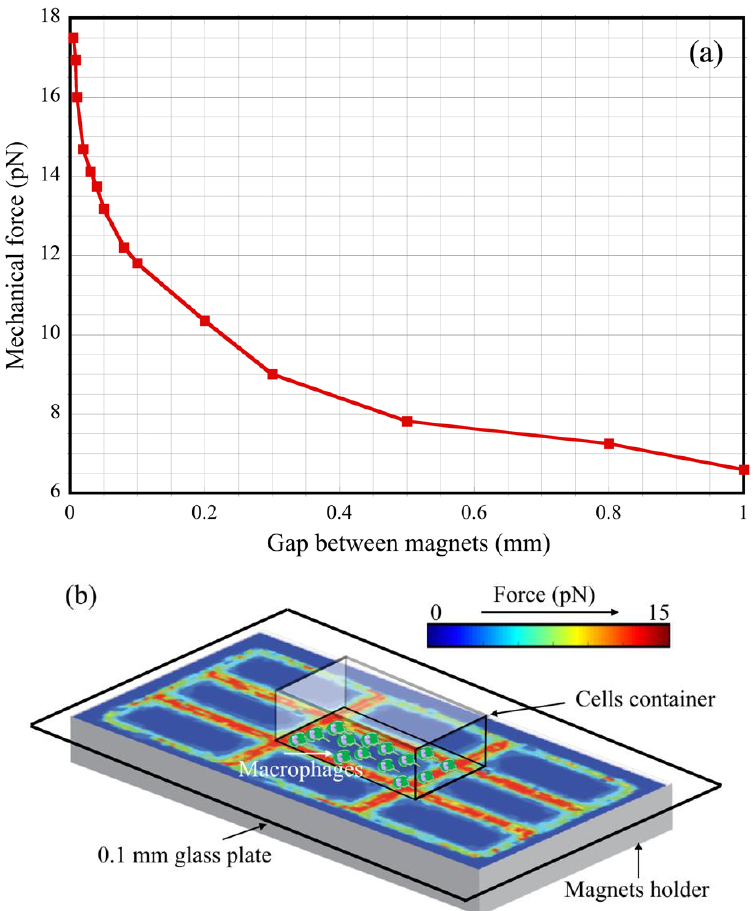
Figure 4. Mechanical force dependence on the magnet separation gap and the distance from magnet interface. ( a ) Calculated force acting on the macrophages shown as a function of the gap size between the magnets for a 0.1 – 1.0 mm range; ( b ) the cell container with macrophages is sketched above the area of interest.